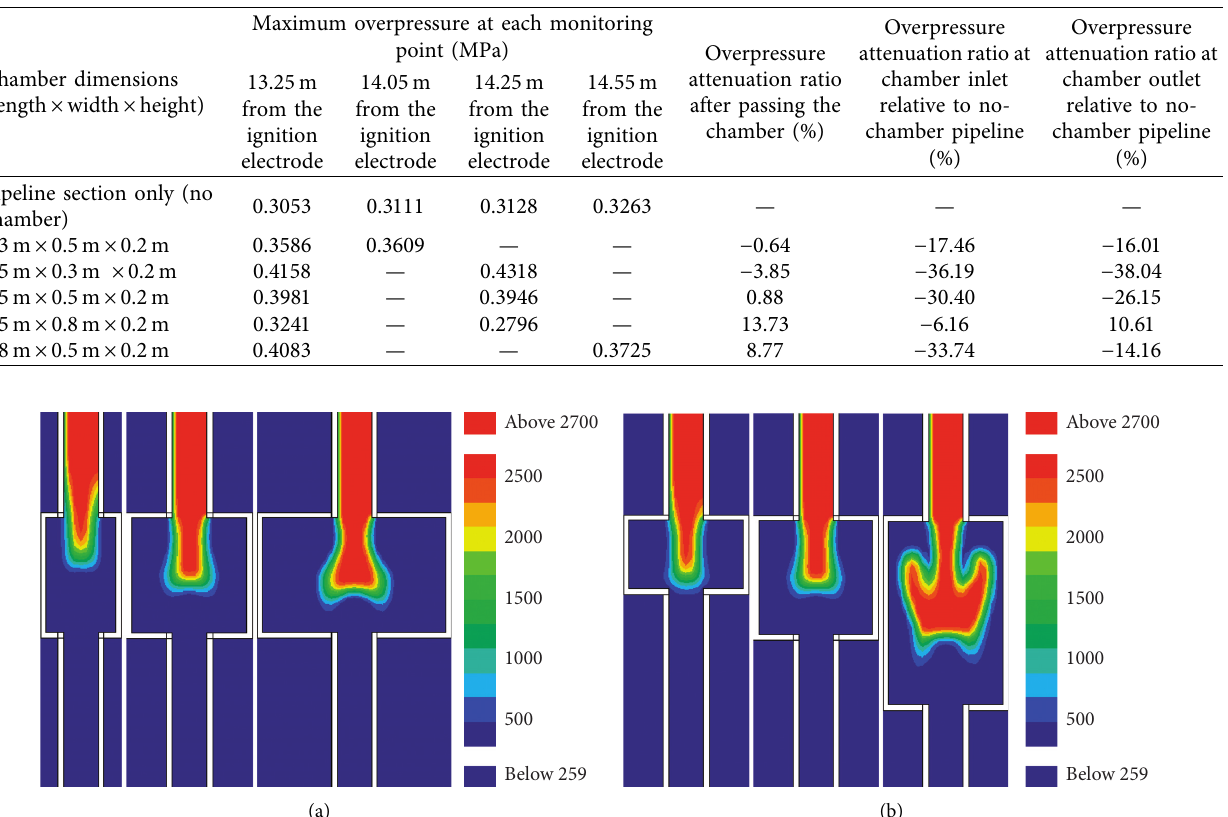
Table 1: Maximum overpressure and overpressure attenuation ratio at each monitoring point of the pipeline section without a chamber and with different chambers.